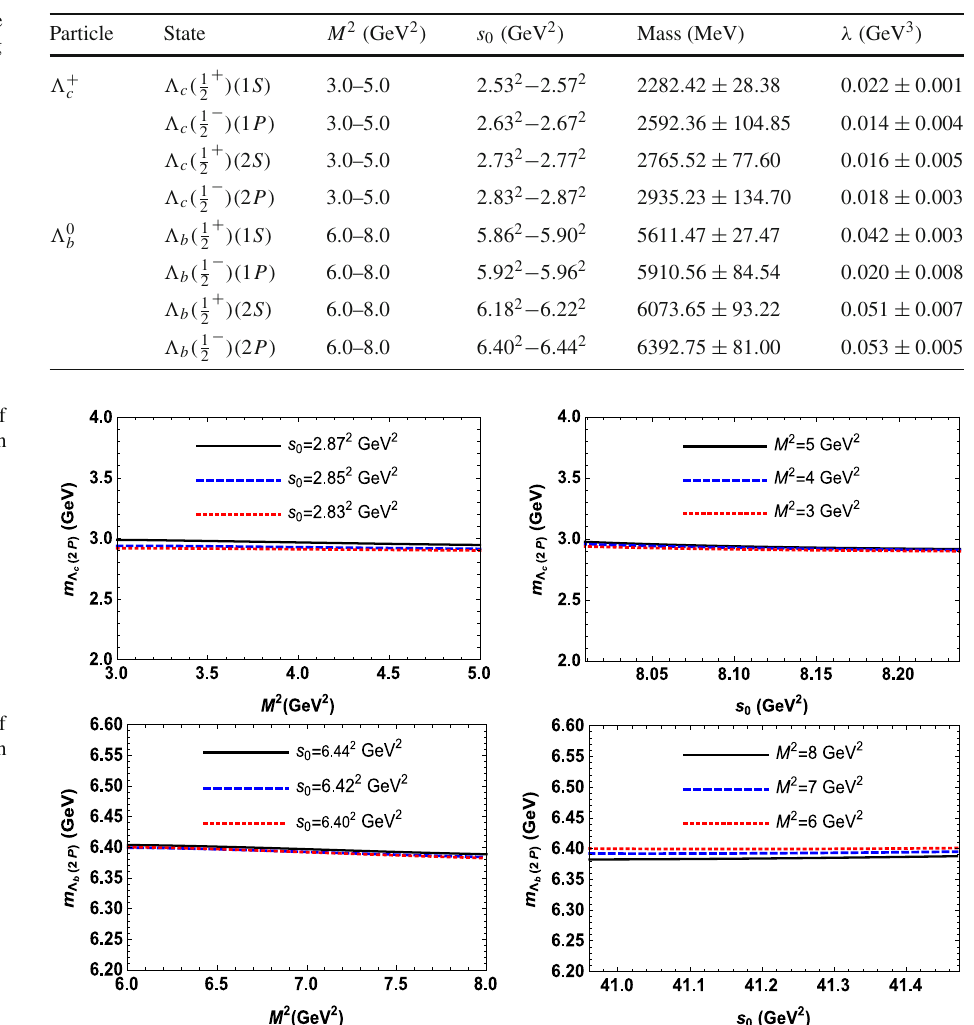
Fig. 3 Left: The dependence of the mass (cid:11) m (cid:5) of the 2 P excitation of (cid:2) b baryon on Borel parameter M 2 . Right: The dependence of the mass (cid:11) m (cid:5) of the 2 P excitation of (cid:2) b baryon on threshold parameter s